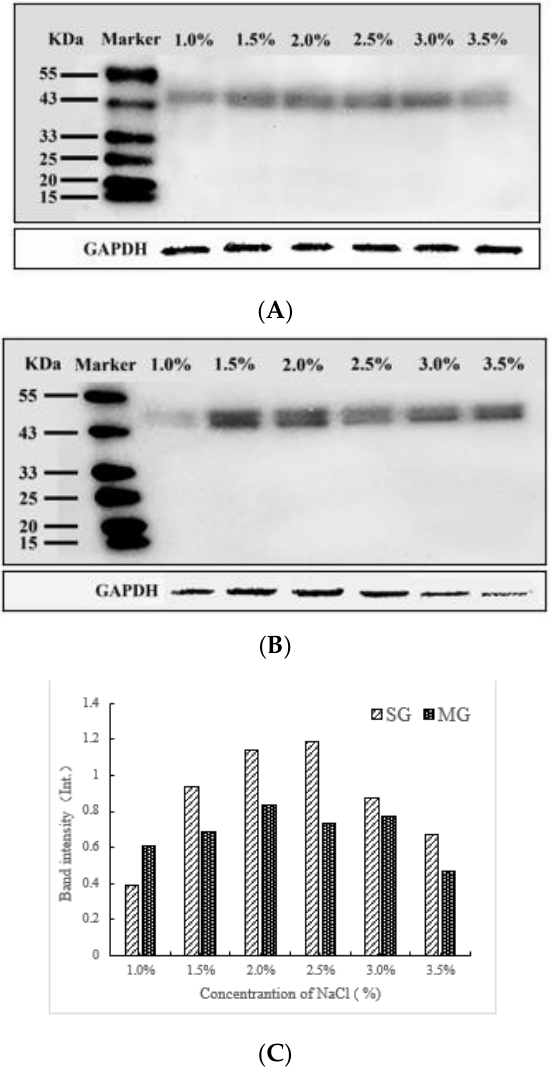
Figure 6. Determination of Western blot of SG ( A ) and MG ( B ) with different NaCl concentrations. ( C ): the intensity of bands in ( A , B ).